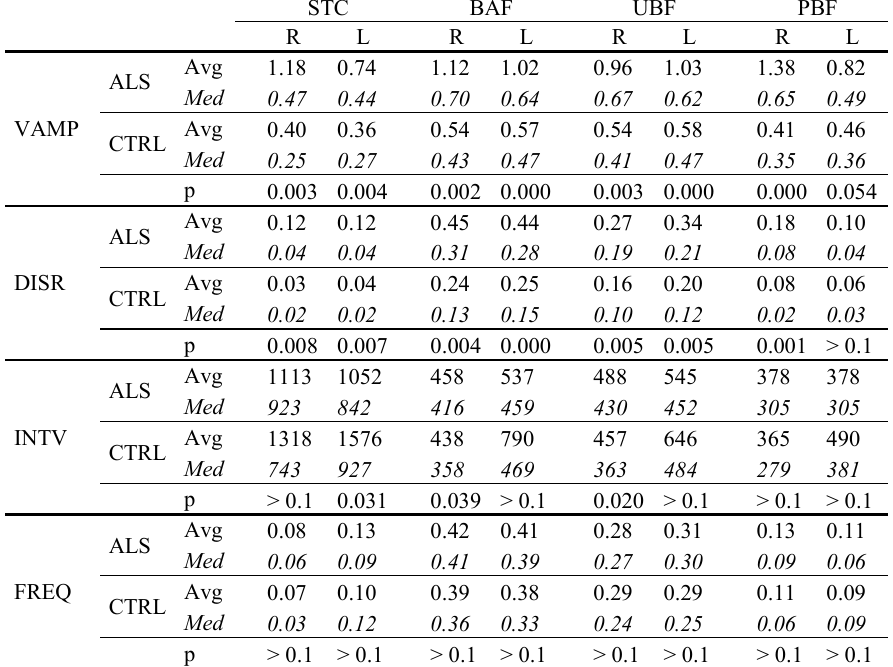
Table 1. Parameters of saccadic intrusions in ALS- patients and controls.